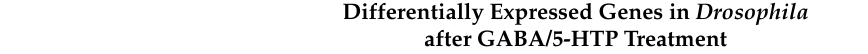
Table 1. The number of differentially expressed genes that satisfied |fold change| ≥ 2 or |fold change| ≥ 4 in the Drosophila